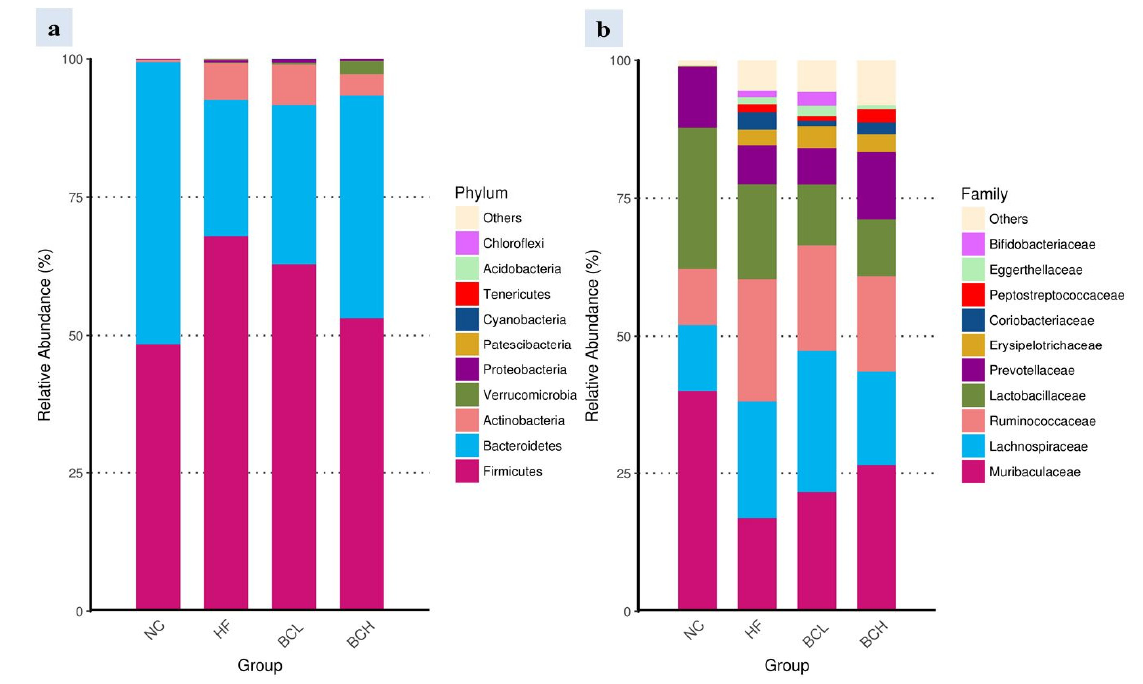
Figure 2. Analysis of bacterial composition in gut microbiota within rats fed chow diet (NC group), high-fat diet (HF group), high-fat diet + low dose of B. coagulan BACO-17 (7 log CFU/day) (BCL group), and high-fat diet + high dose of B. coagulan BACO-17 (9 log CFU/day) (BCH group) ( n = 5 per group). The top 10 relative abundance of the bacterial taxon shown at the level of ( a ) phylum and ( b ) family.